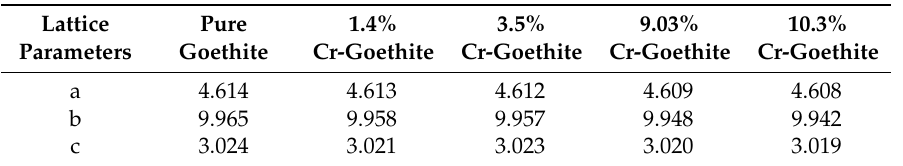
Figure 3. ( a ) k3-weighted extended X-ray absorption fine structure (EXAFS) spectra (solid line) and linear combination fits (dotted line) for 10.3% Cr-substituted goethite, ( b ) the X-ray absorption near edge structure (XANES) spectra for the Cr k-edge of 10.3% Cr-goethite. Table 1. The lattice parameters of pure goethite and Cr-substituted goethites (Cr-goethites) calculated from their X-ray diffraction (XRD) patterns presented in Figure 1. Cr-substituted goethites are represented by numbers defining their ratios of [Cr]:([Cr] + [Fe]).